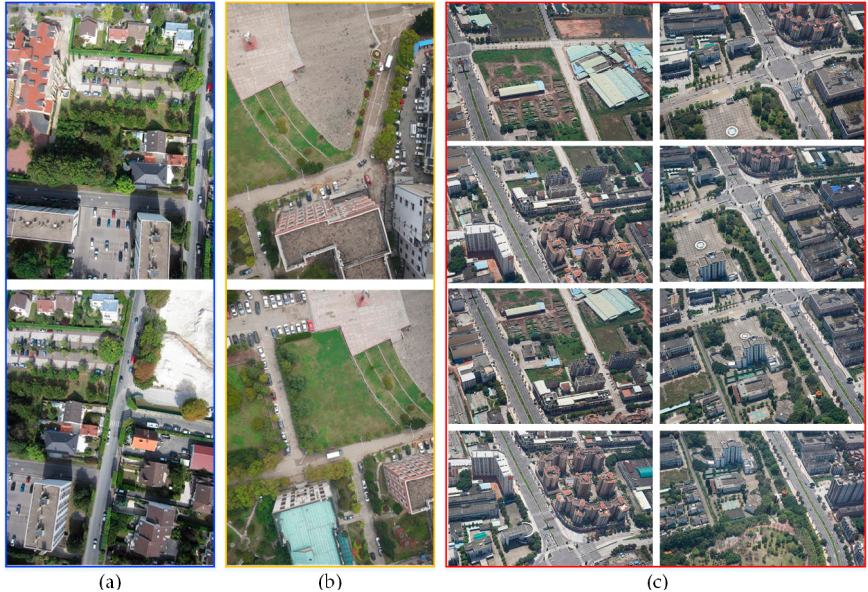
Figure 7. Three groups of experimental unmanned aerial vehicle (UAV) images. ( a ) The first image pair; ( b ) The second image pair; ( c ) The sequence images of a single-strip.